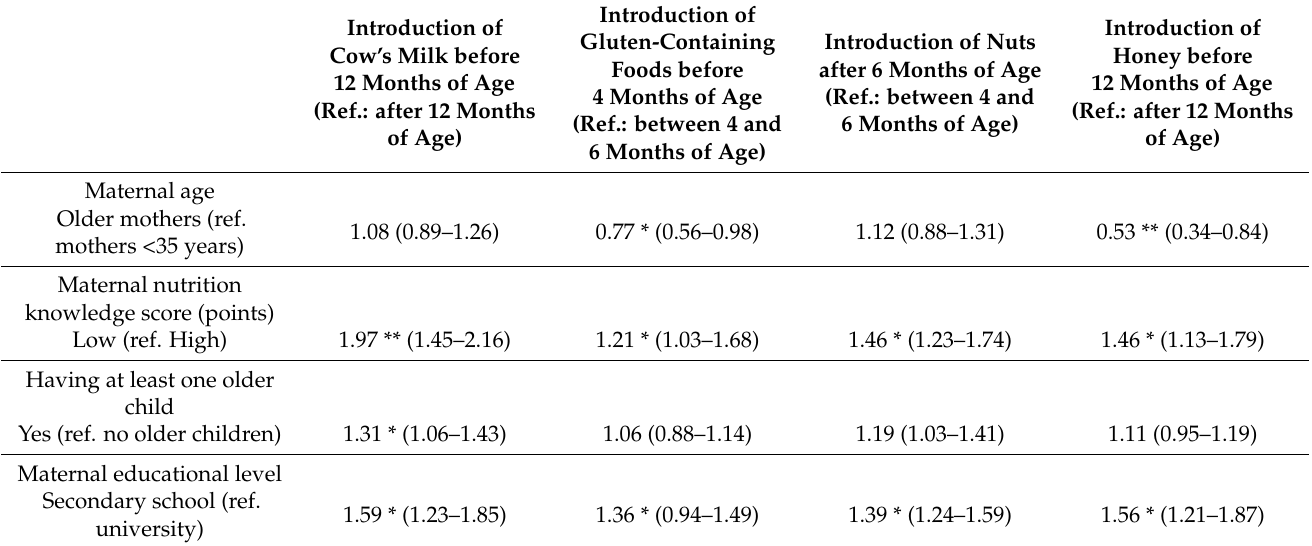
Table 3. Odds ratios (95% confidence interval). The associations between maternal factors and the introduction of gluten, cow’s milk and honey according to Polish